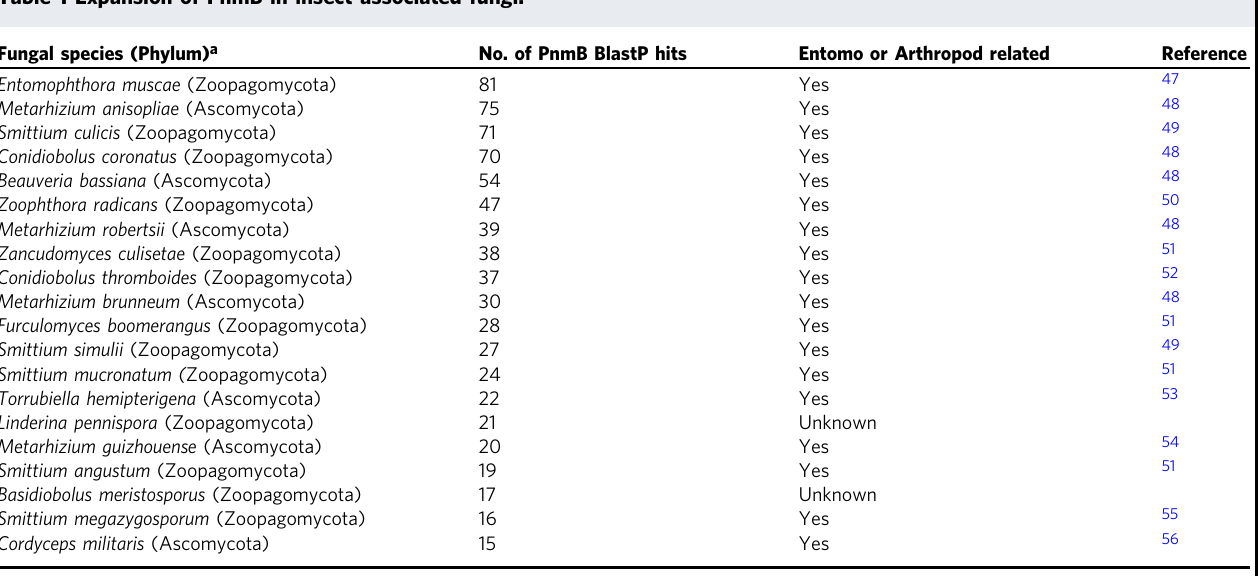
Table 1 Expansion of PnmB in insect-associated fungi. Fungal species (Phylum) a